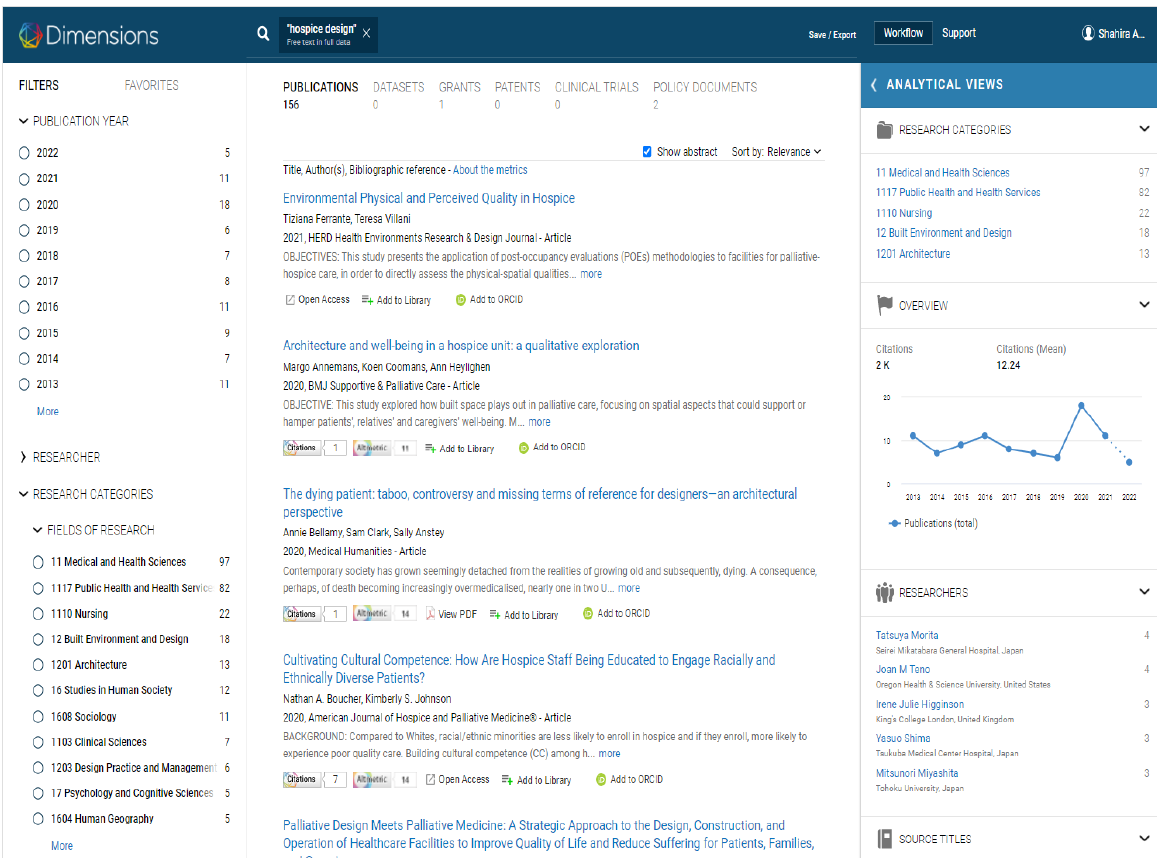
Figure 2: results from the dimensions.ai application showing the number of search items that resulted from the keywords While in Scopus database, the term “palliative care design” came up with 123 entries, and “hospice care design” came up with 28, ( Figure 3 and 4 respectively).